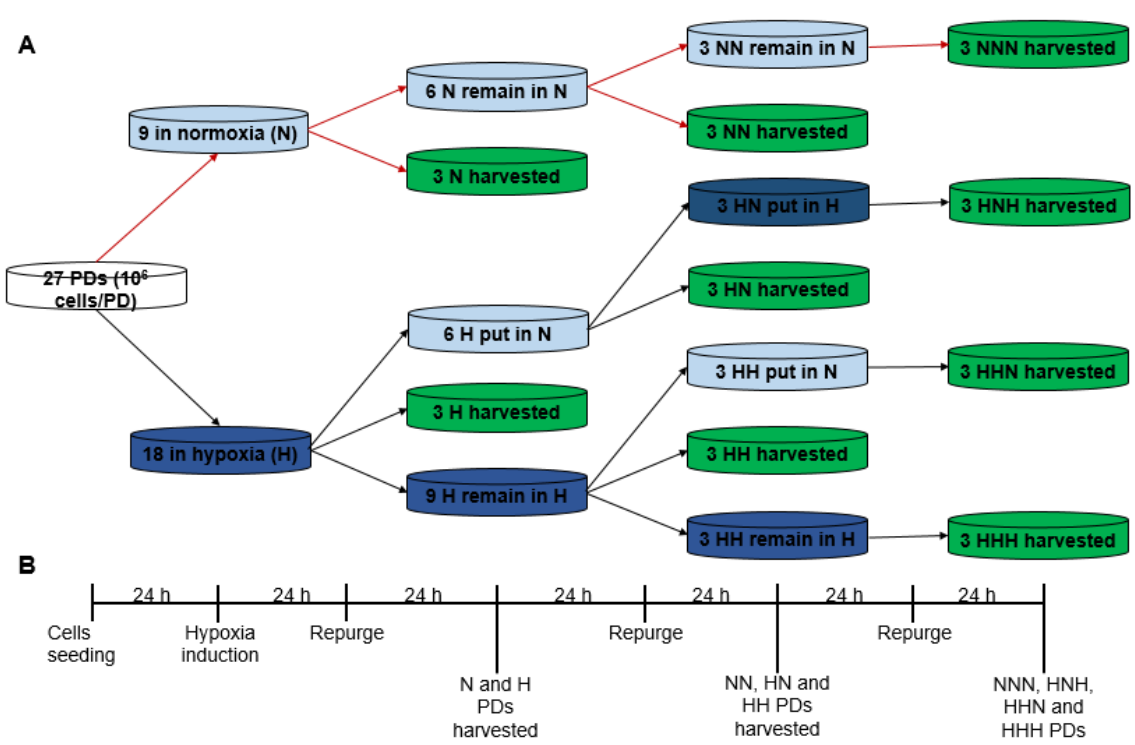
Figure 2. Schematic representation ( A ) and timeframe ( B ) of the cell growth dynamics experiment under normoxia (N, NN and NNN); hypoxia (H, HH and HHH) and intermittent hypoxia (HN, HNH and HHN) performed on colon HT-29, breast MDA-MB-231 and ovarian SKOV-3 cancer cells.